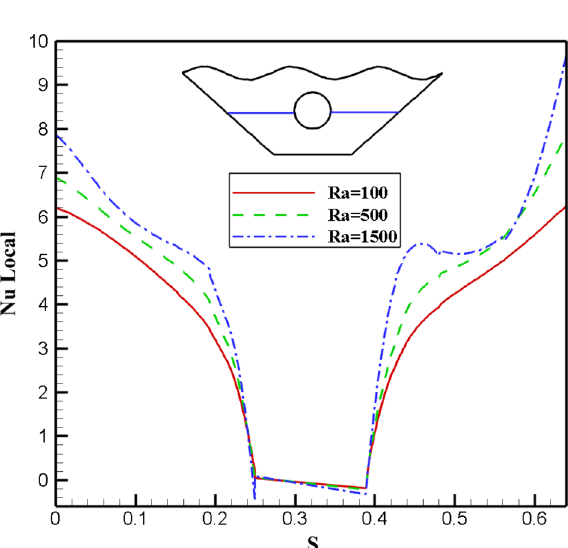
Figure 12. Local Nu number plot for different Ra numbers